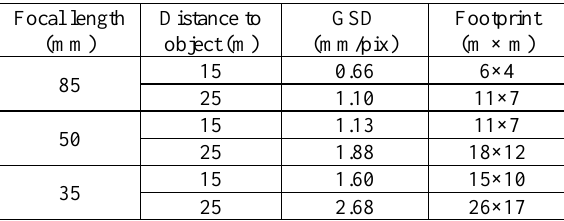
Table 1. Parameters based on 3 standard lenses of the camera Sony Alpha 7R IV with different distances to